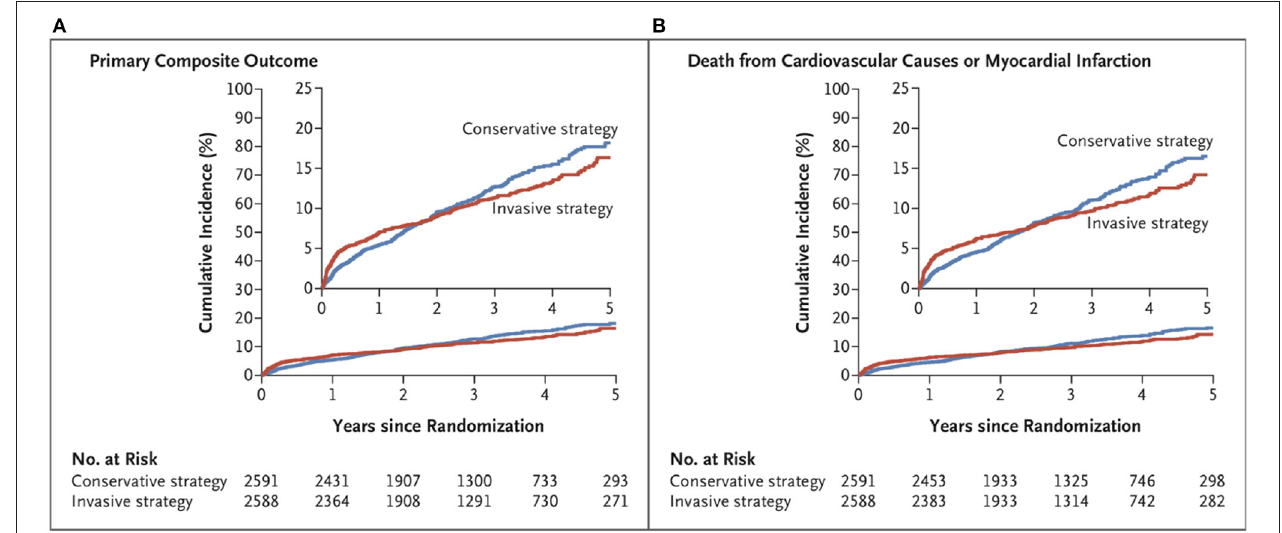
FIGURE 1 | Cumulative incidence curves for the primary composite outcome and other outcomes, from ISCHEMIA trial (5). (A) shows the cumulative incidence of the primary composite outcome of death from cardiovascular causes, myocardial infarction, or hospitalization for unstable angina, heart failure, or resuscitated cardiac arrest in the conservative-strategy group and the invasive- strategy group. (B) shows the cumulative incidence of death from cardiovascular causes or myocardial